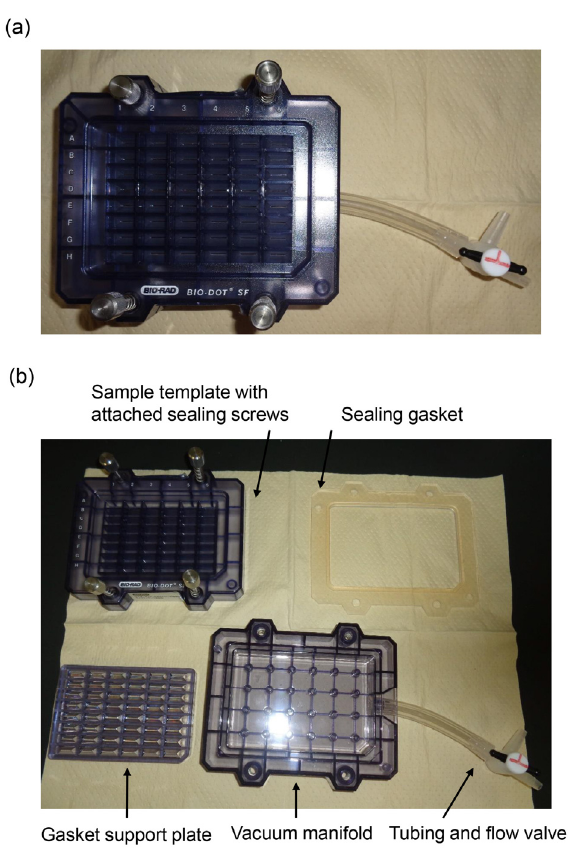
Figure 1. Bio-Dot SF Microfiltration Apparatus (slot blot apparatus with 48 lanes). ( a ) Assembly of the apparatus. ( b ) Parts of the disassembled apparatus.